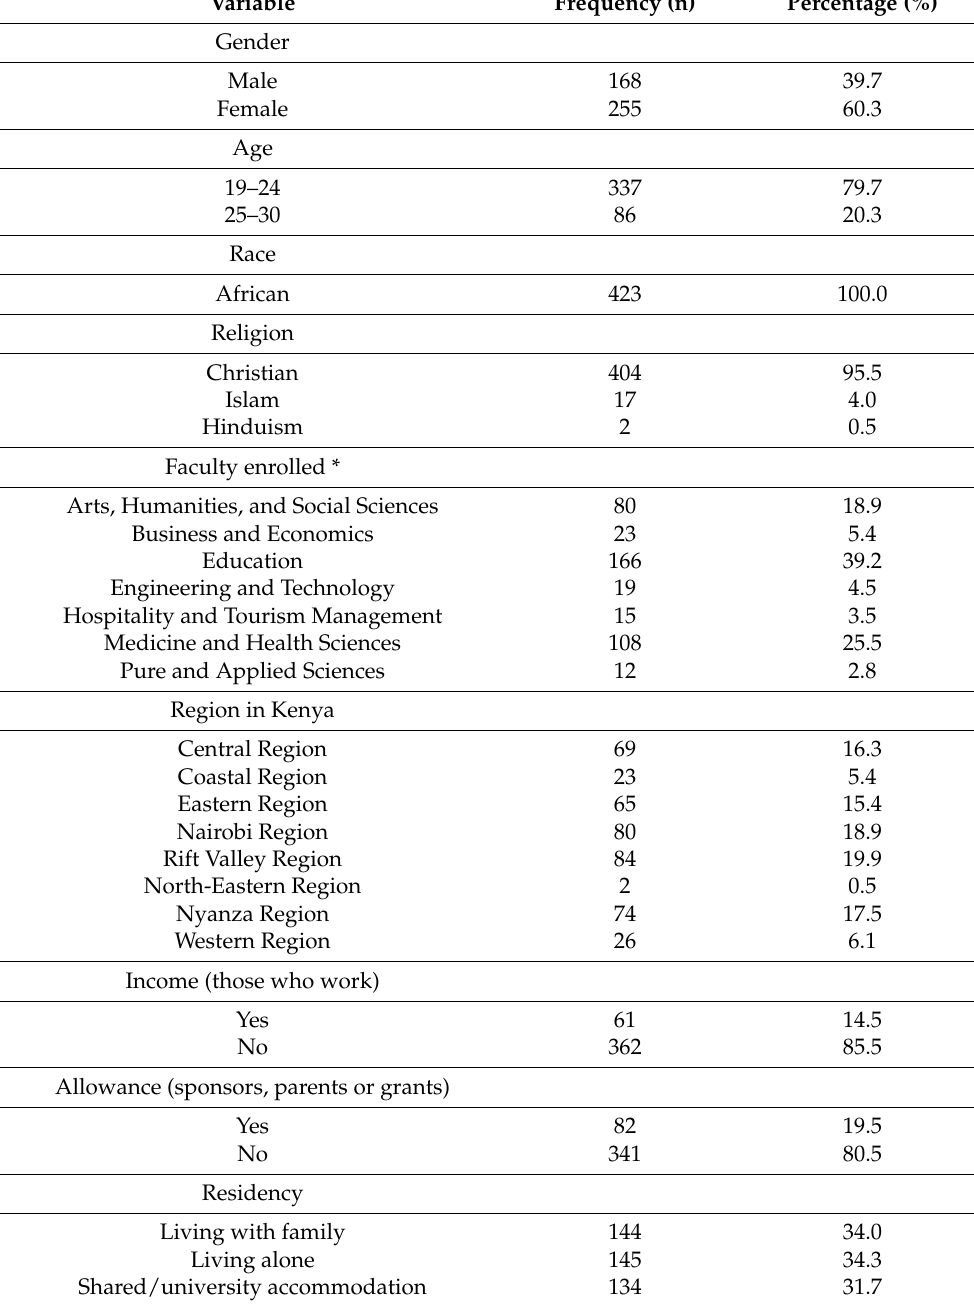
Table 1. Demographic and socioeconomic characteristics of the study